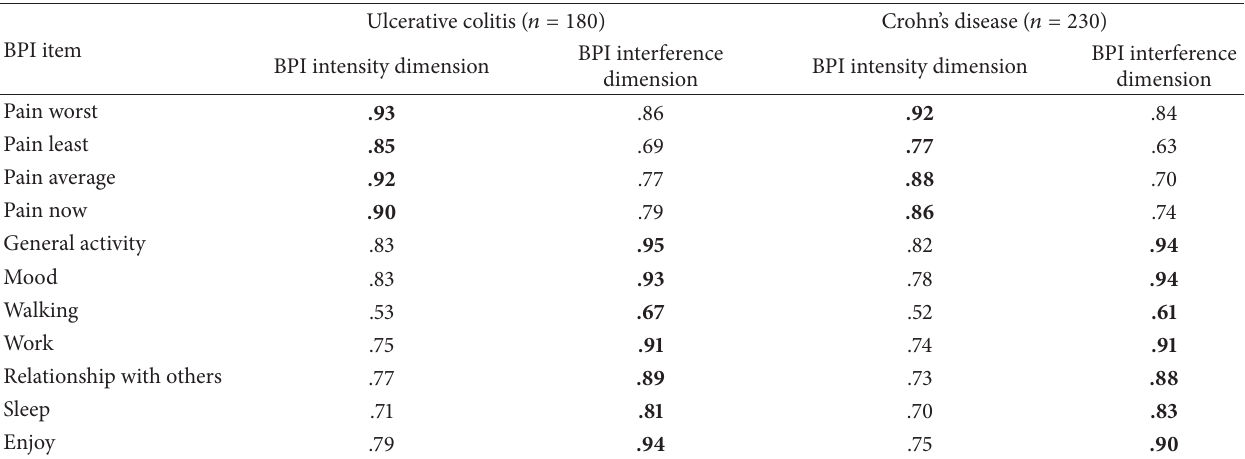
Table 4: Spearman correlation between individual BPI items and BPI dimensions.